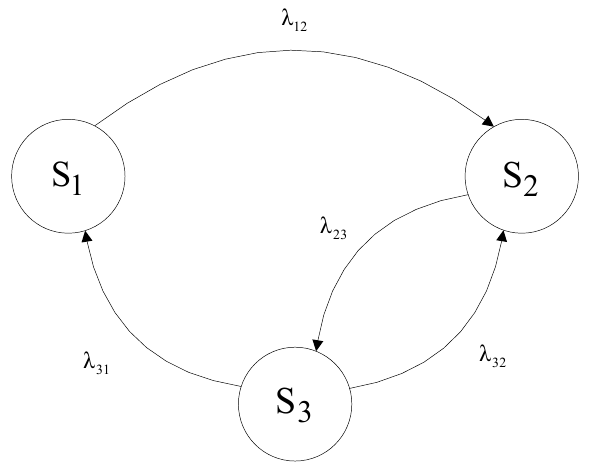
Figure 1. Graph of the toll station operation process, taking into account the intensity of transitions. Source: own study.